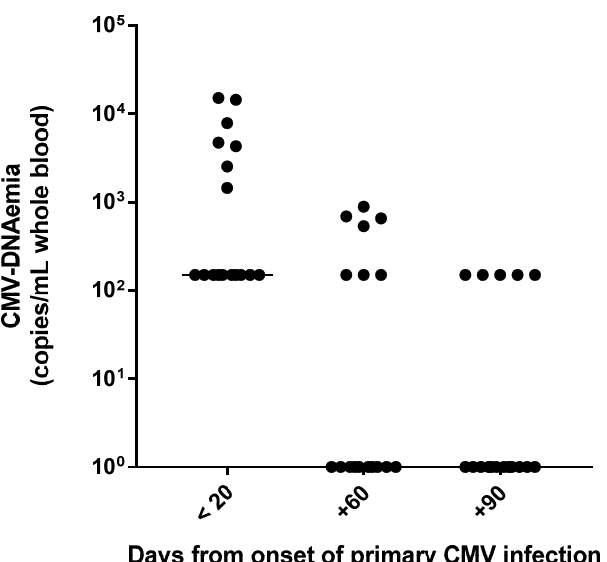
Figure 3. CMV-DNAemia values during the three-month follow-up after primary CMV infection. The resolution of symptomatology occurred after a median time of 5 weeks (range,